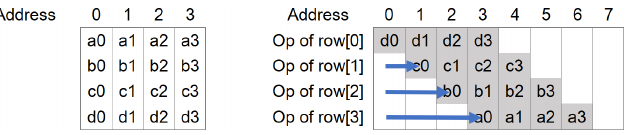
Figure 15: Output operations restored from U in entry of memory while the row represents the bit